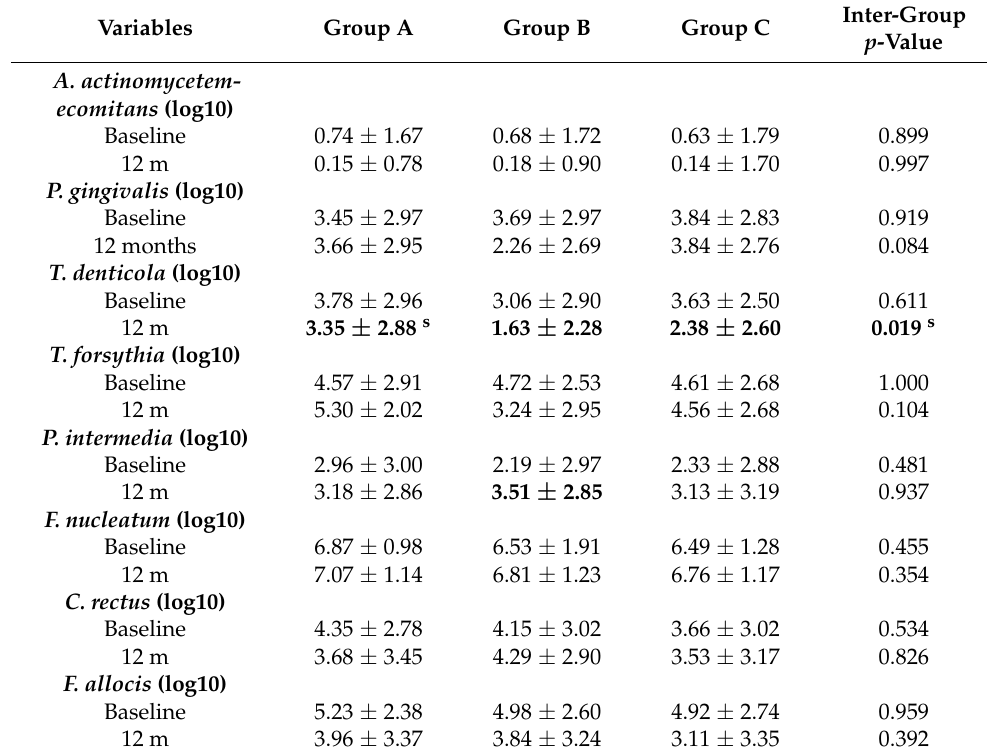
Table 3. Mean counts (log10) ± SD of periodontal pathogens in all treatment groups (A: PDT, B: LDDs, C: control) at baseline and after 12 months (Kruskal–Wallis test, Friedman